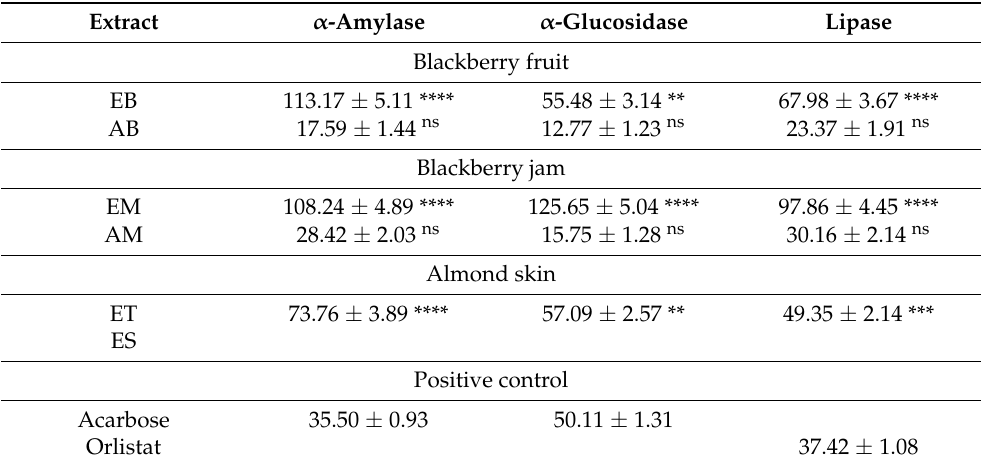
Table 6. Hypoglycaemic and hypolipidemic activity [IC 50 ( µ g/mL)] of investigated